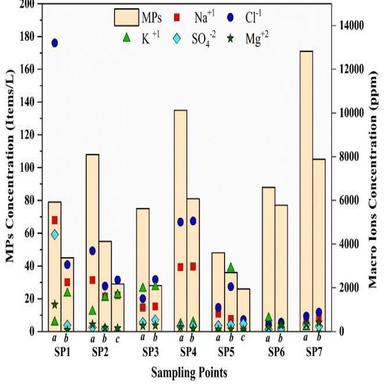
MPs and macro ions concentration in GW at different depth and sampling points (SP).